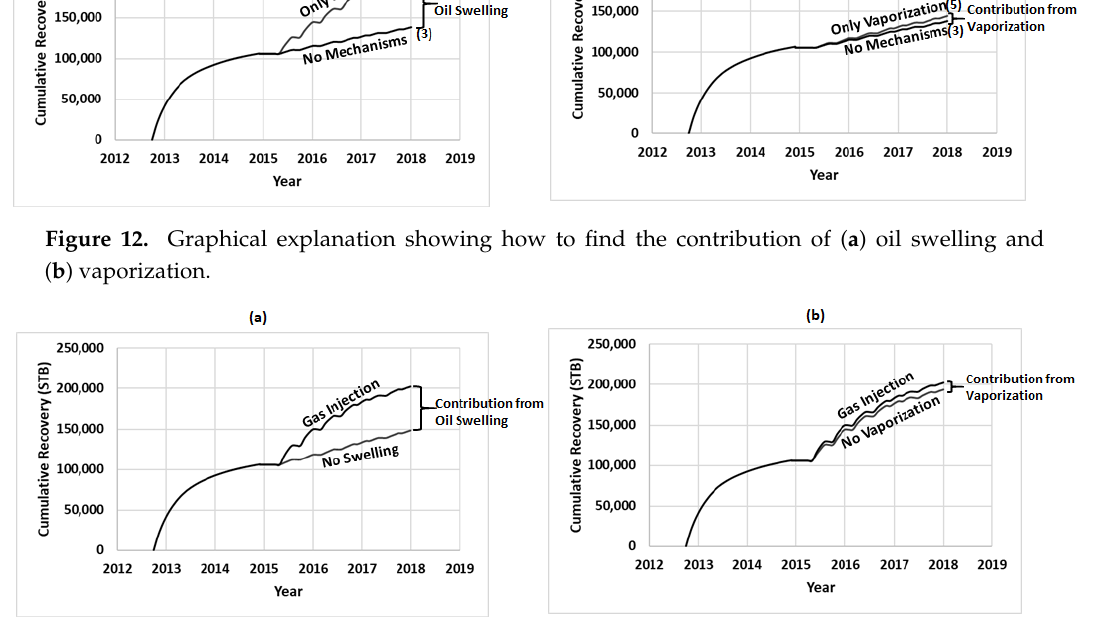
Figure 12. Graphical explanation showing how to find the contribution of ( a ) oil swelling and ( b ) vaporization.